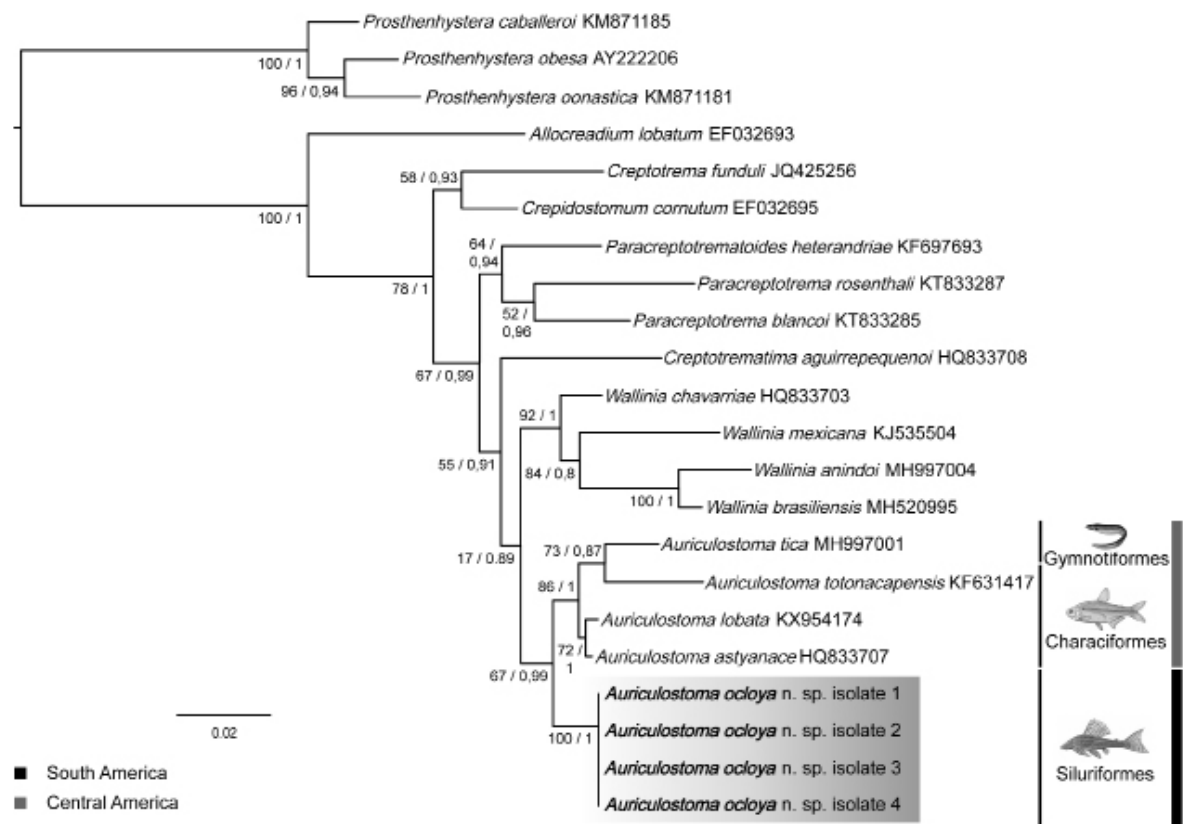
Figure 4. Phylogenetic tree based on Bayesian inference and Maximum likelihood analyses of the 28S dataset showing the relationship between the new species and the other species of Auriculostoma . Order of host and geographical origin of each species of the Auriculostoma are indicated. Values above the branches represent Bayesian inference posterior probabilities (PP) followed by the Maximum likelihood bootstrap support